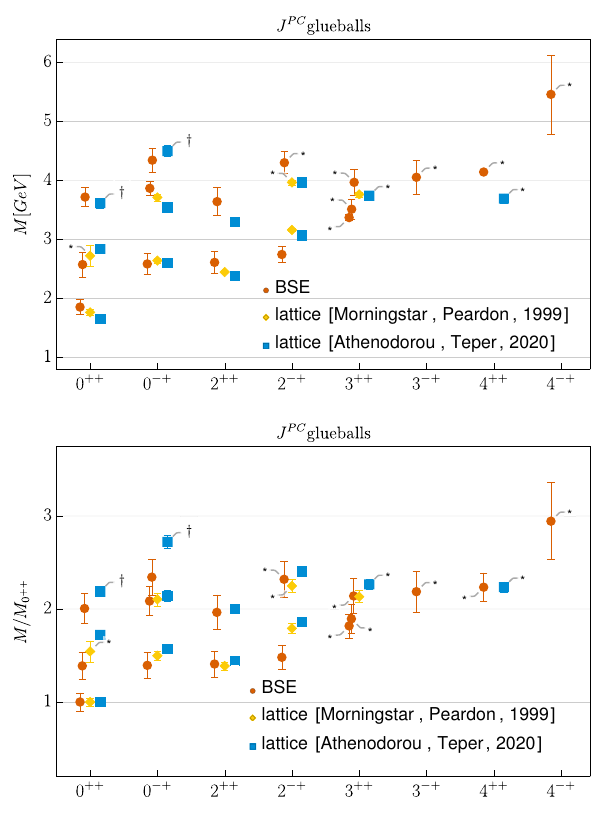
Figure 2. Results for glueball ground states and excited states for the indicated quantum numbers from lattice simulations [15, 19] and functional equations. In the upper plot, we display the glueball masses on an absolute scale set by r 0 = 1 / 418(5)MeV). In the lower plot, we display the spectrum relative to the ground state. Masses with † are conjectured to be the second excited states. Masses with ∗ come with some uncertainty in their identification in the lattice case or in the trustworthiness of the extrapolated value in the BSE